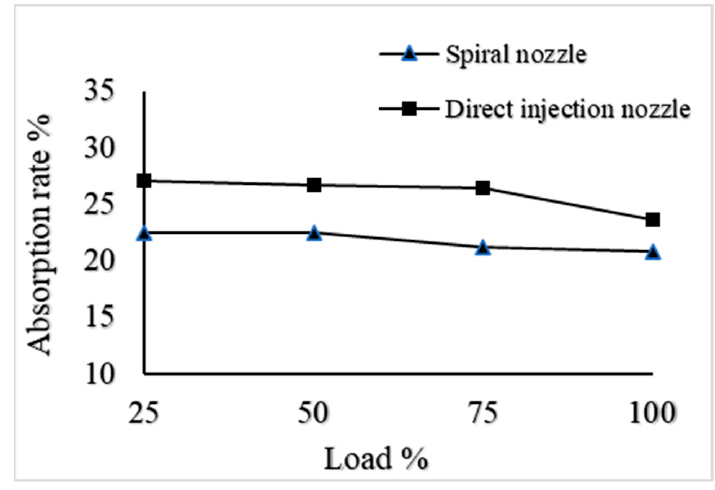
Figure 12. CO 2 absorption rate with different types of